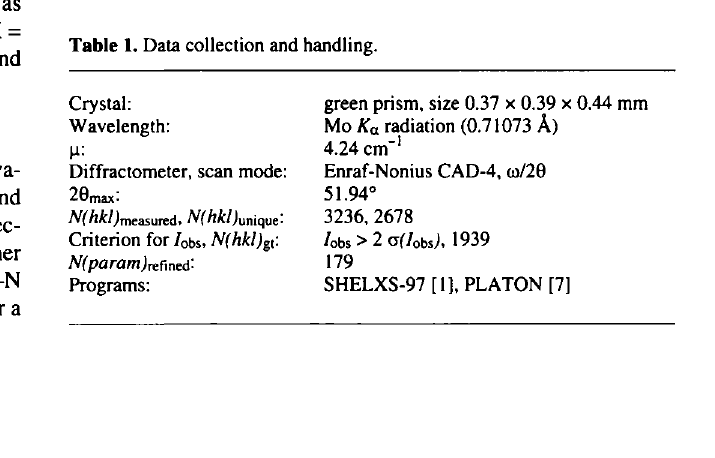
Table 1. Data collection and